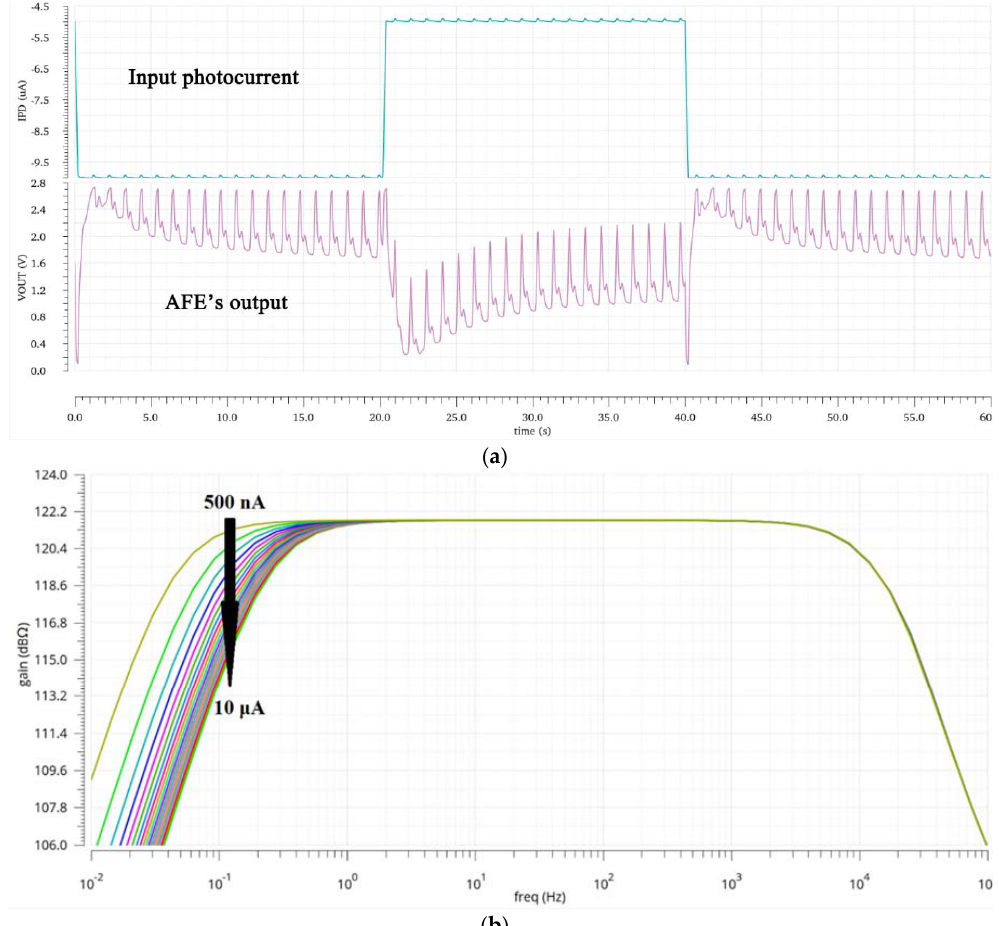
Figure 6 . The simulation result of TIA. Transient response ( a ) and frequency response ( b ) with different BGL levels. In (a), I PD (cid:48) s DC level changes between 5 and 10 µ A while the PPG signal is maintained as 0.1 µ A peak-to-peak.